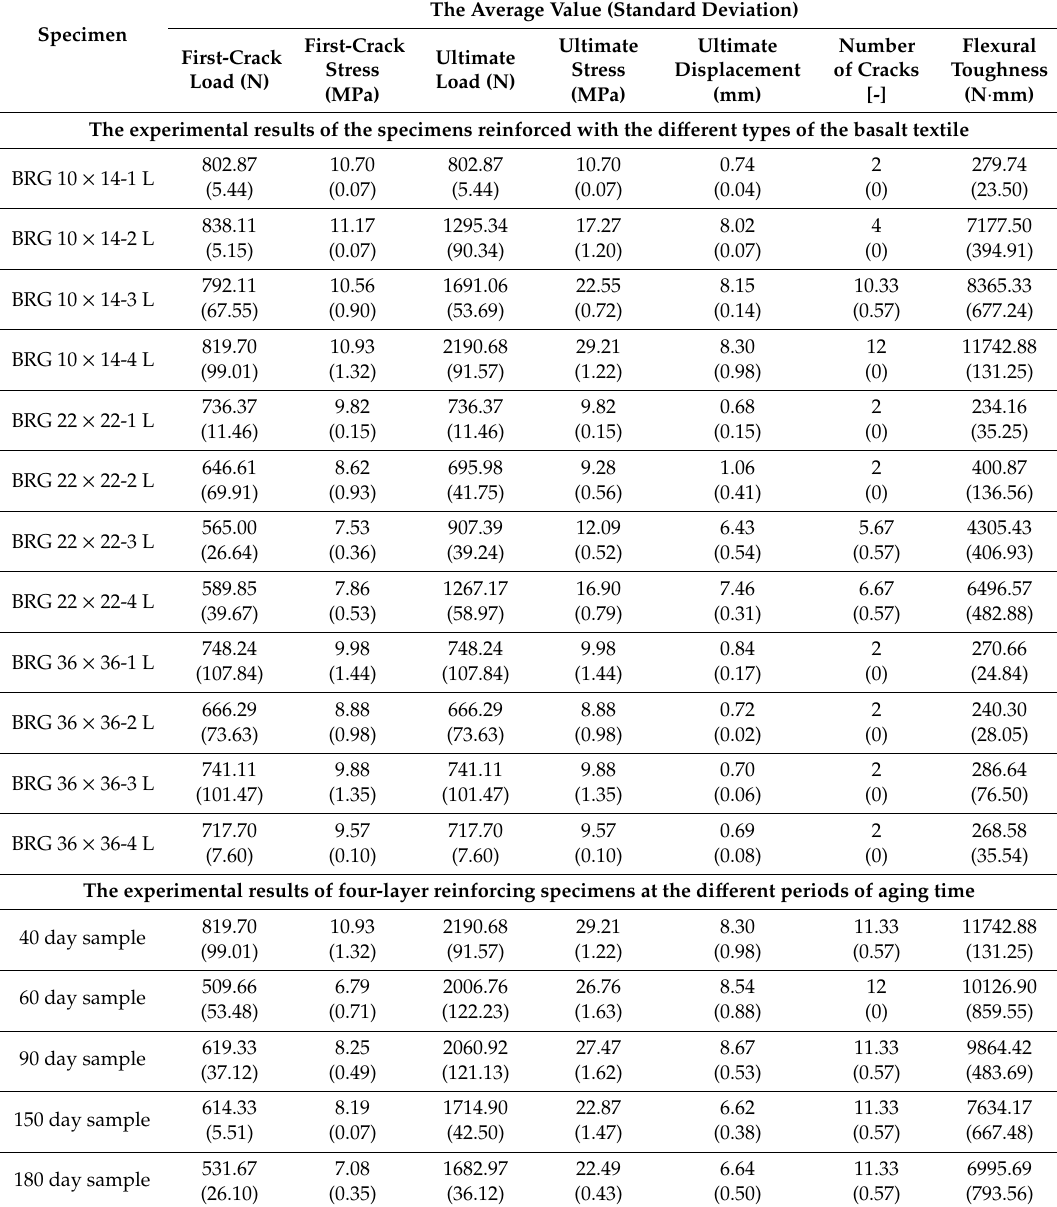
Table 3. Summary of the experimental results of BRG